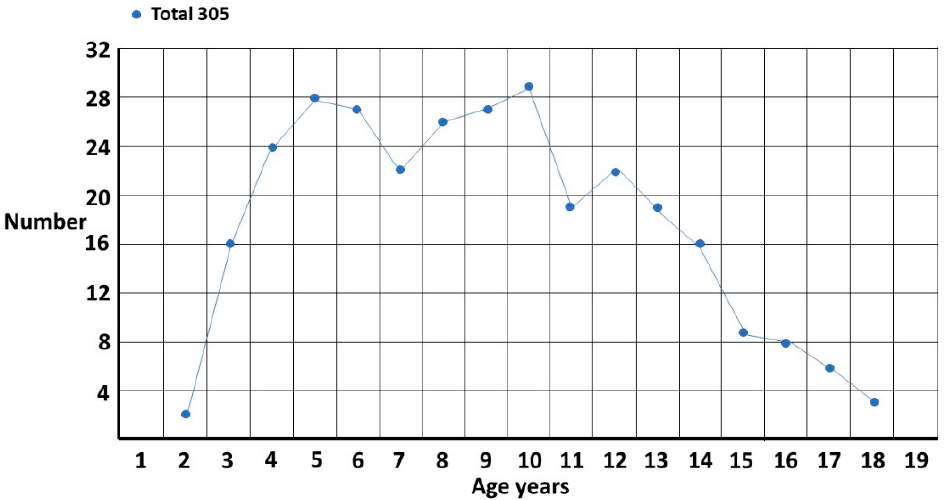
Figure 1. Female singletons diagnosed per year of age.